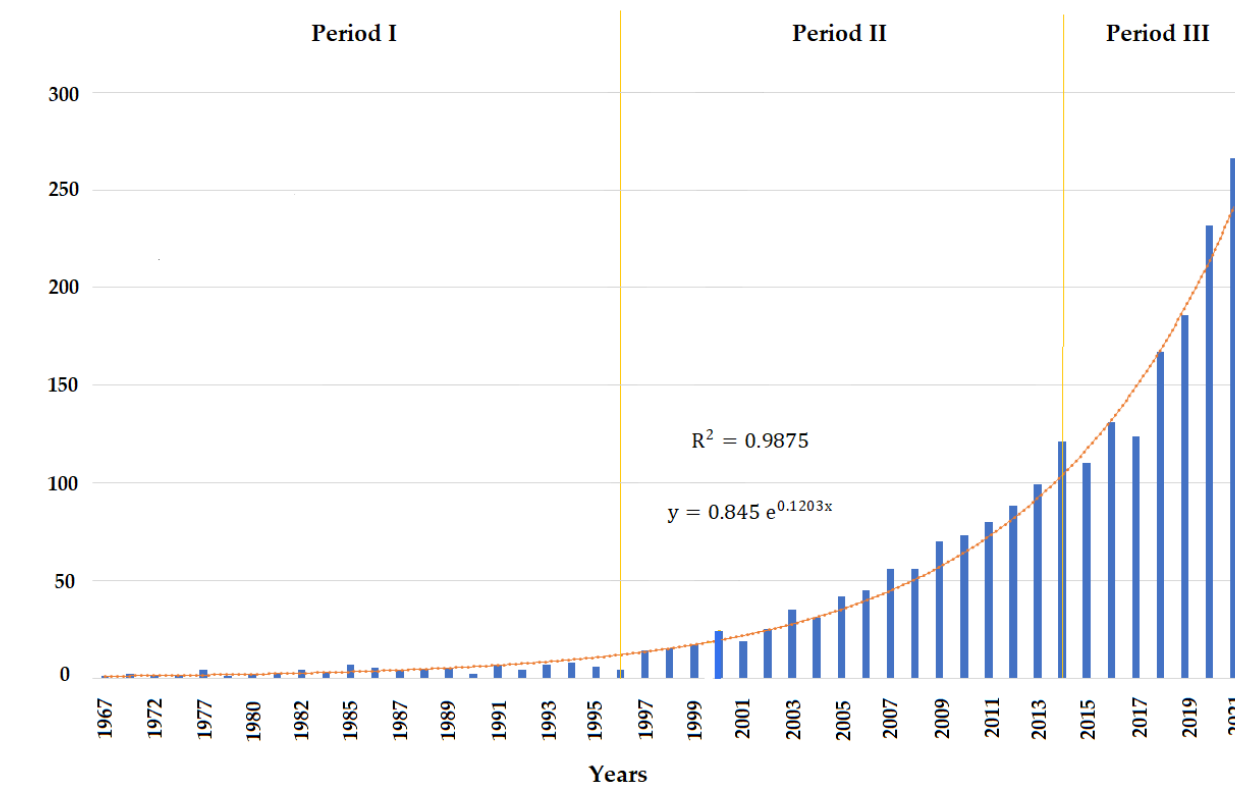
Figure 2. Annual scientific production on water scarcity in semi-arid areas.